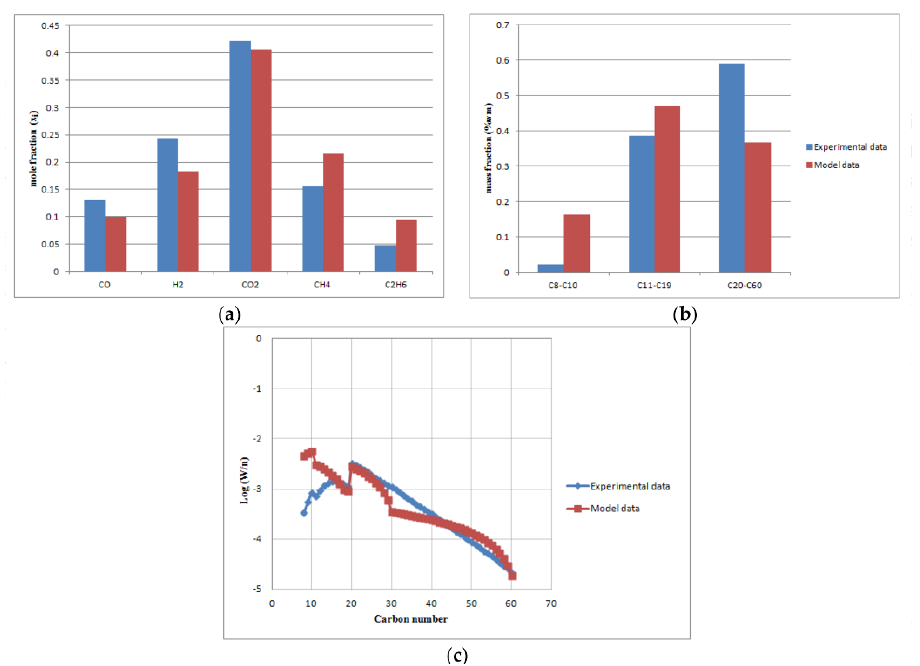
Figure 5. The comparison of the predicted model with experimental data at base load conditions (volumetric gas flow rate 5 m 3 /h, T = 503 K, ε cat = 0.34, P = 20 bar): ( a ) off-gas molar